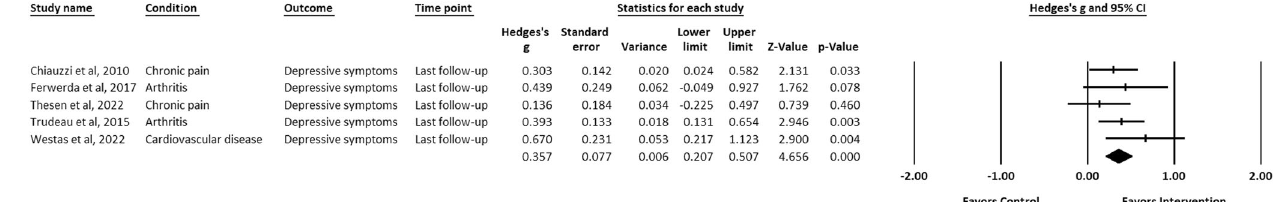
Fig. 8 Forest plot for effect sizes of IM-CBT on depressive symptoms at last follow-up.